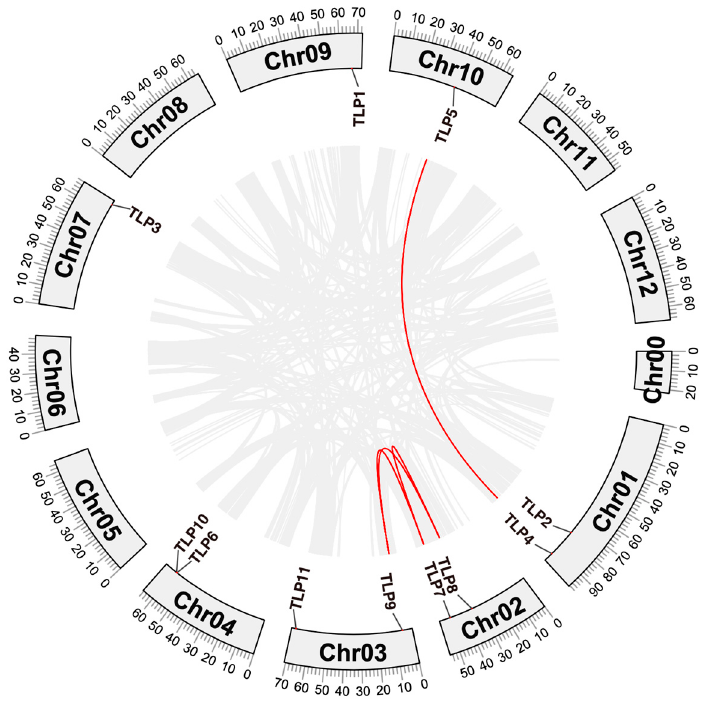
Figure 3. Chromosomal location and homology analysis of TLPs in tomato.